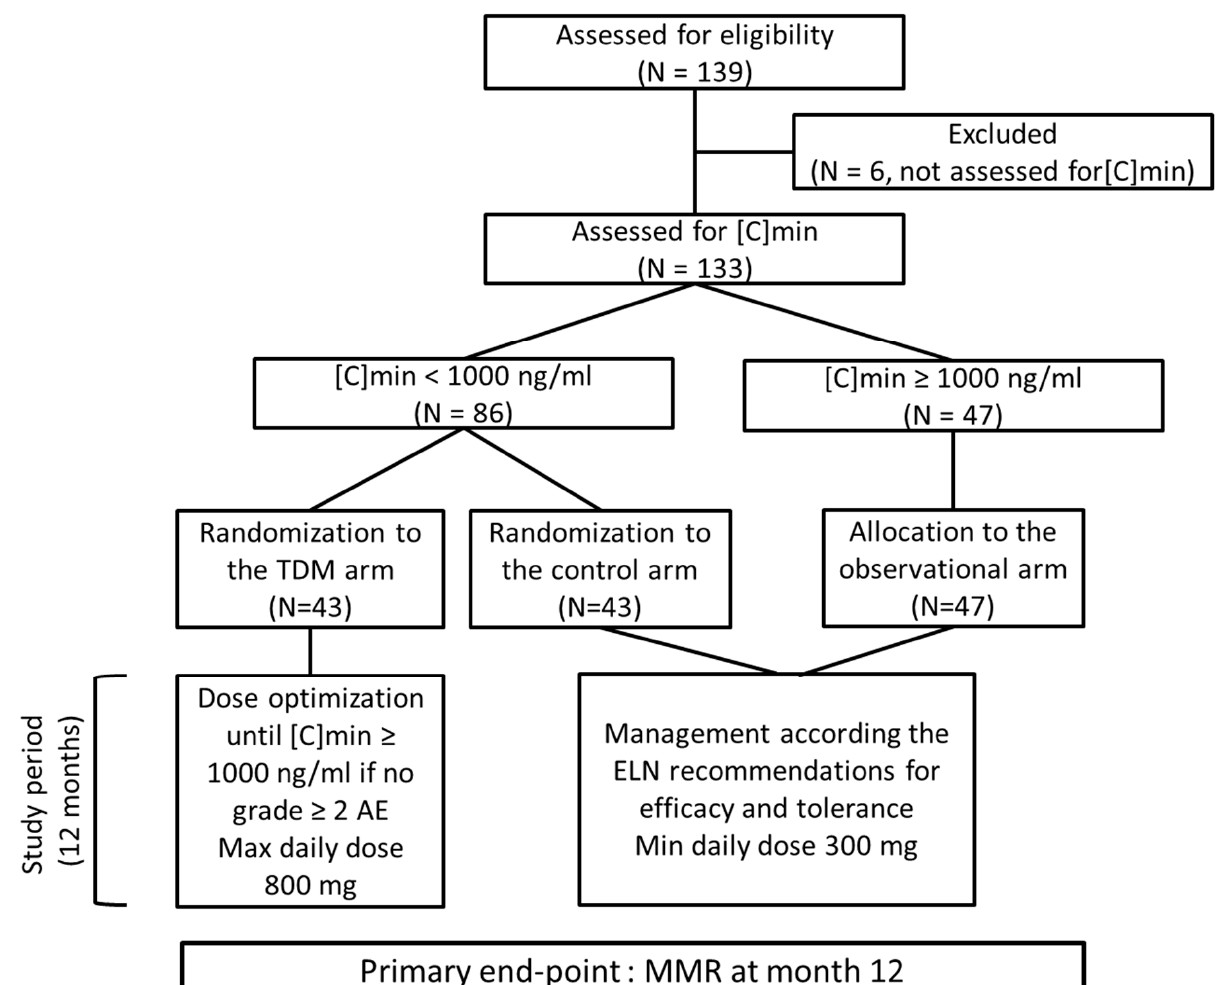
Figure 1. CONSORT diagram of the OPTIM-imatinib study. [C]min: trough imatinib plasma level, ELN: European Leukemia Net, AE: adverse event. Table 1. Characteristics of the patients included in the OPTIM-imatinib trial.